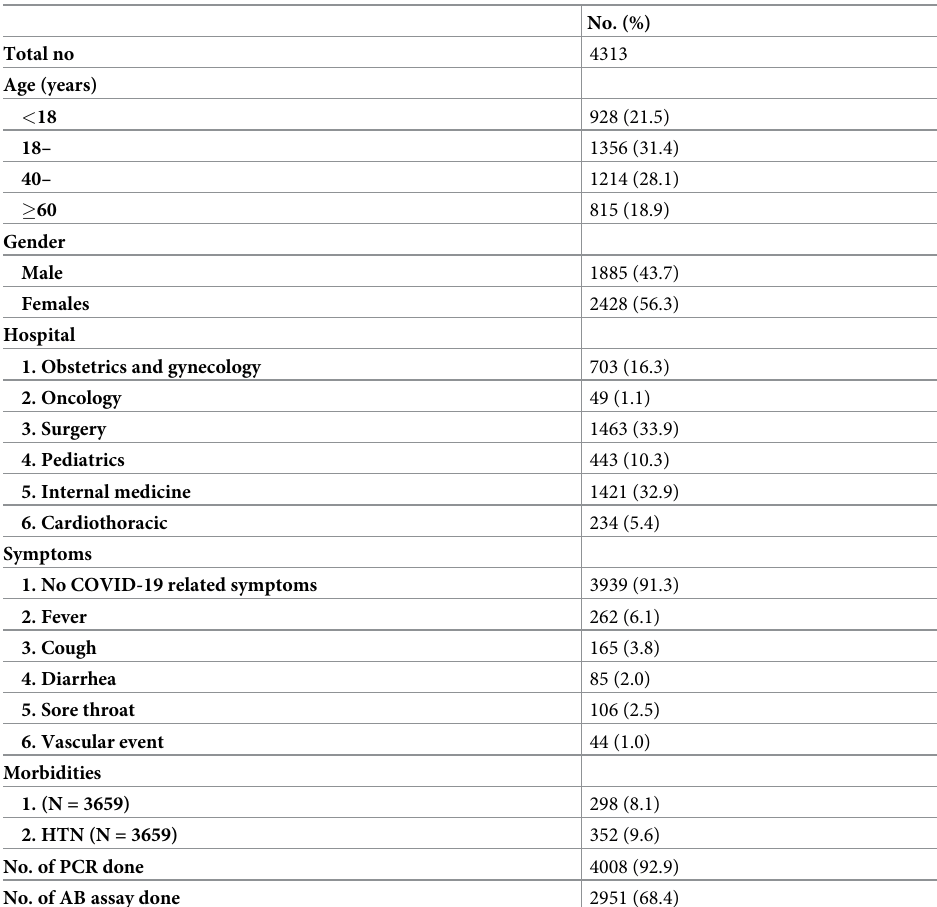
Table 1. Characteristics of the study